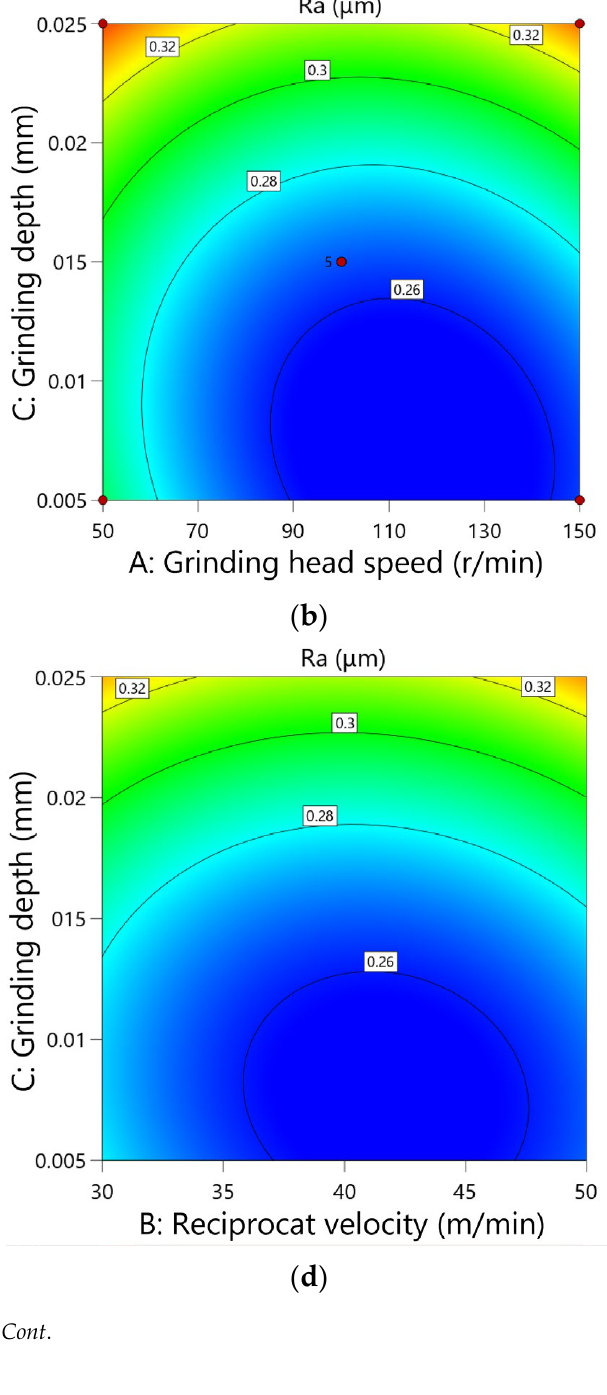
( f ) Figure 8. Response surface plot and projected contour plot of interaction. ( a ) Response surface of grinding depth and grinding head speed when the reciprocat velocity is 40 m/min. ( b ) Contour of grinding depth and grinding head speed